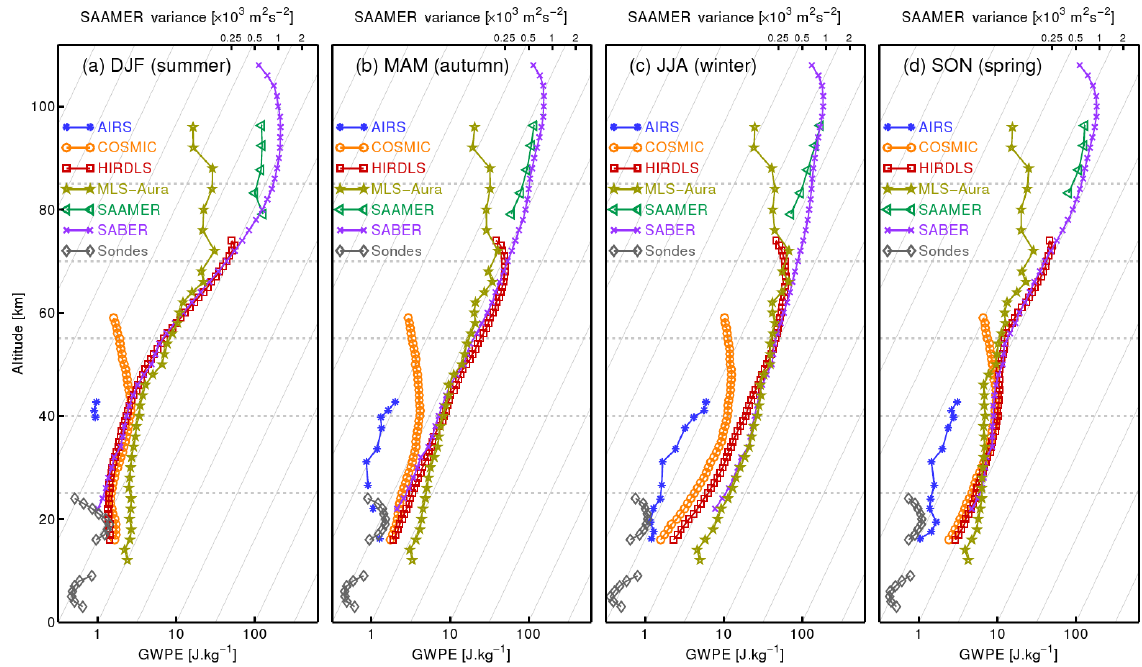
Figure 11. As Fig. 10, but sorted by season rather than by